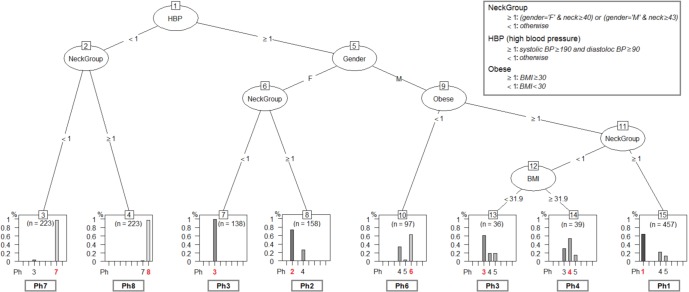
The phenotype classifying tree, obtained by running evtree on patients from APD.Each new person is assigned to one of the eight phenotypes, denoted as Ph1–Ph8 (dominant phenotypes are emphasized). Decisions are made according to some of the six relevant parameters (gender-G, age- A, body mass index-BMI, systolic blood pressure-SBP, diastolic blood pressure-DBP, Epworth sleepiness score-ESS), but also according to variables computed from the six parameters (High Blood Pressure-HBP, Neck Group-NG, Obesity-Ob), as described in the figure legend.